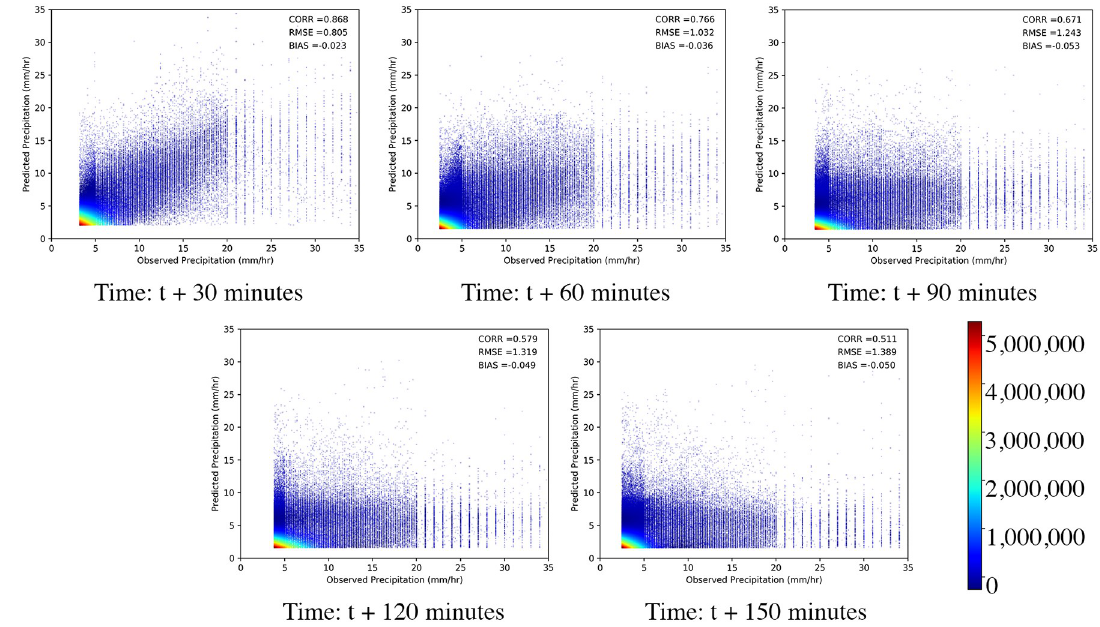
Fig 8. Scatter density plots of magnitude of observed precipitation and predicted precipitation with lead